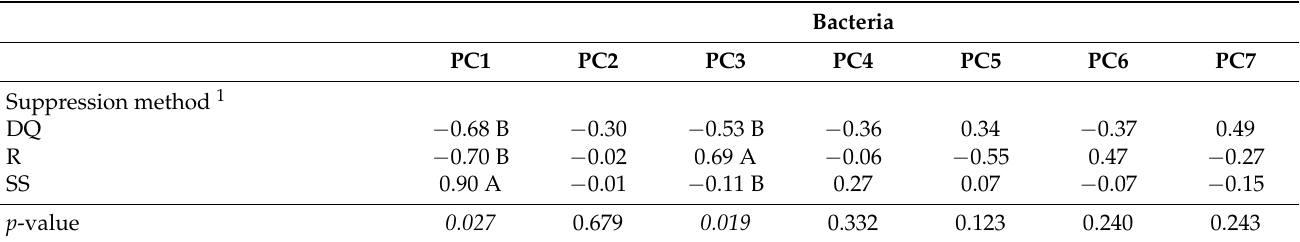
Table 4. Mean values and probability values ( p -values) associated with the analysis of variance (ANOVA) results for the effects of the suppression method on each group of principal components (PCs) calculated for Bacteria datasets comprised of indicator ASVs.